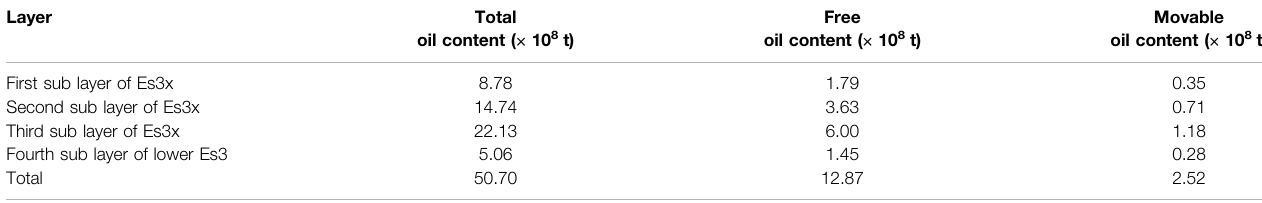
TABLE 1 | Statistics of resources of each small layer in Es3x.